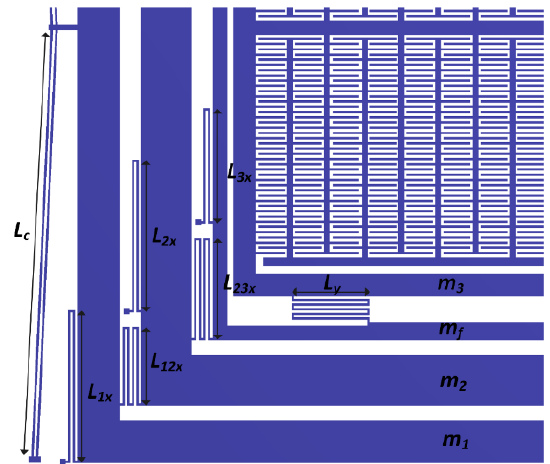
Figure 3. Drive and sense mode flexural suspension for the proposed MEMS gyroscope.